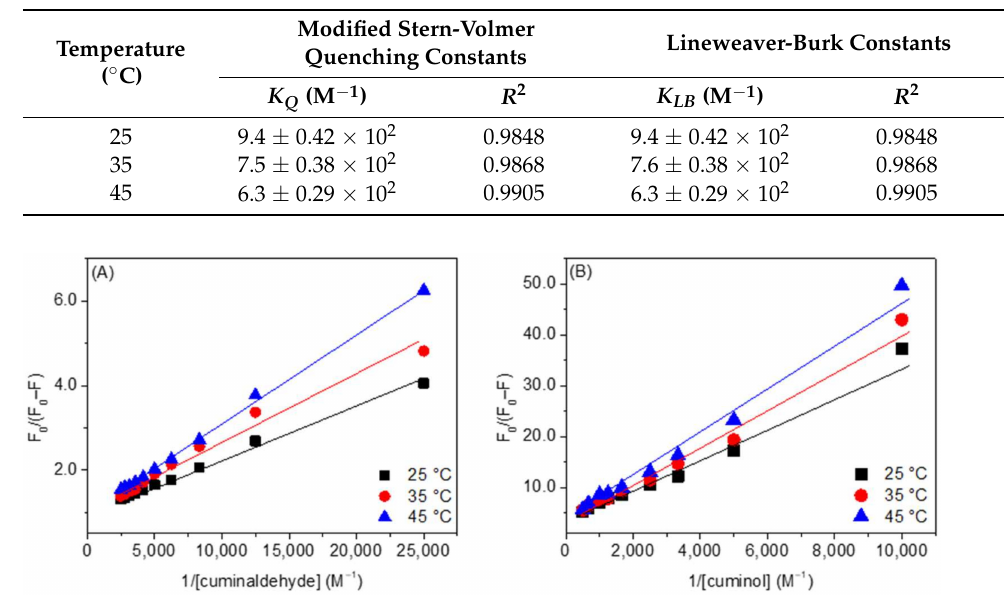
Table 2. Modified Stern-Volmer quenching constants and Lineweaver-Burk constants for the interac- tion of HSA with cuminol at various temperatures.